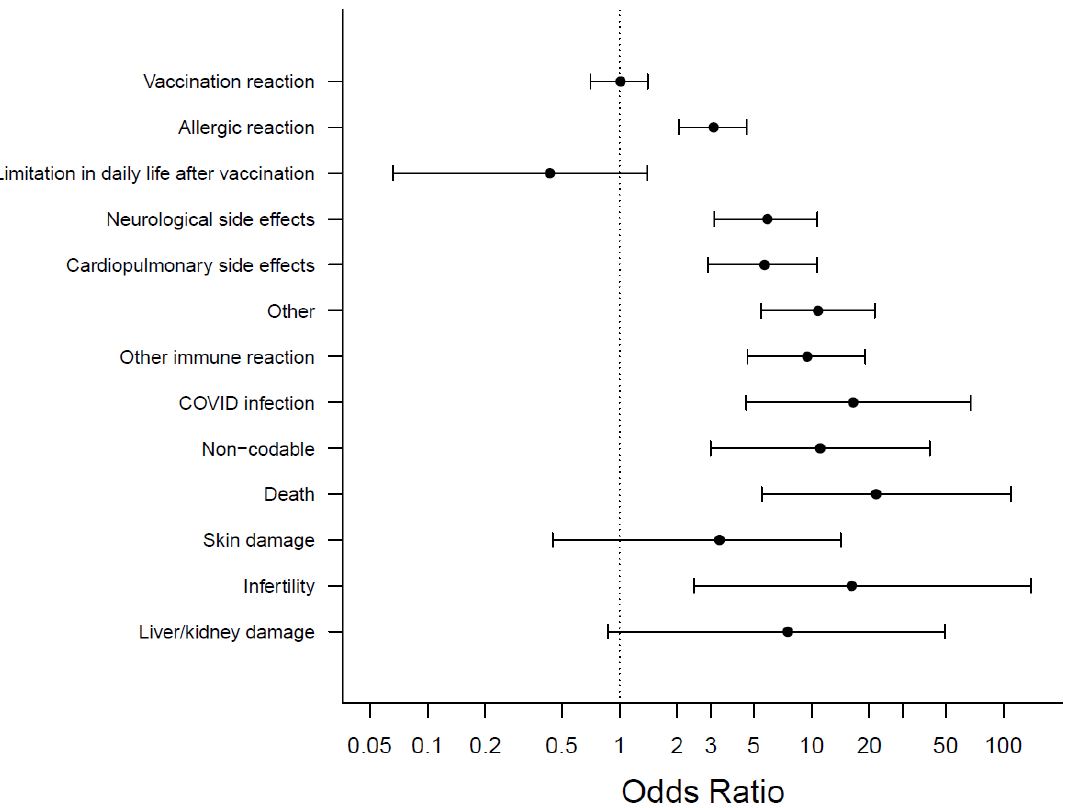
Figure 5. Feared short-term side effects and Odds Ratios for COVID-19 vaccination hesitancy, with categories arranged by frequency, most frequent on top.